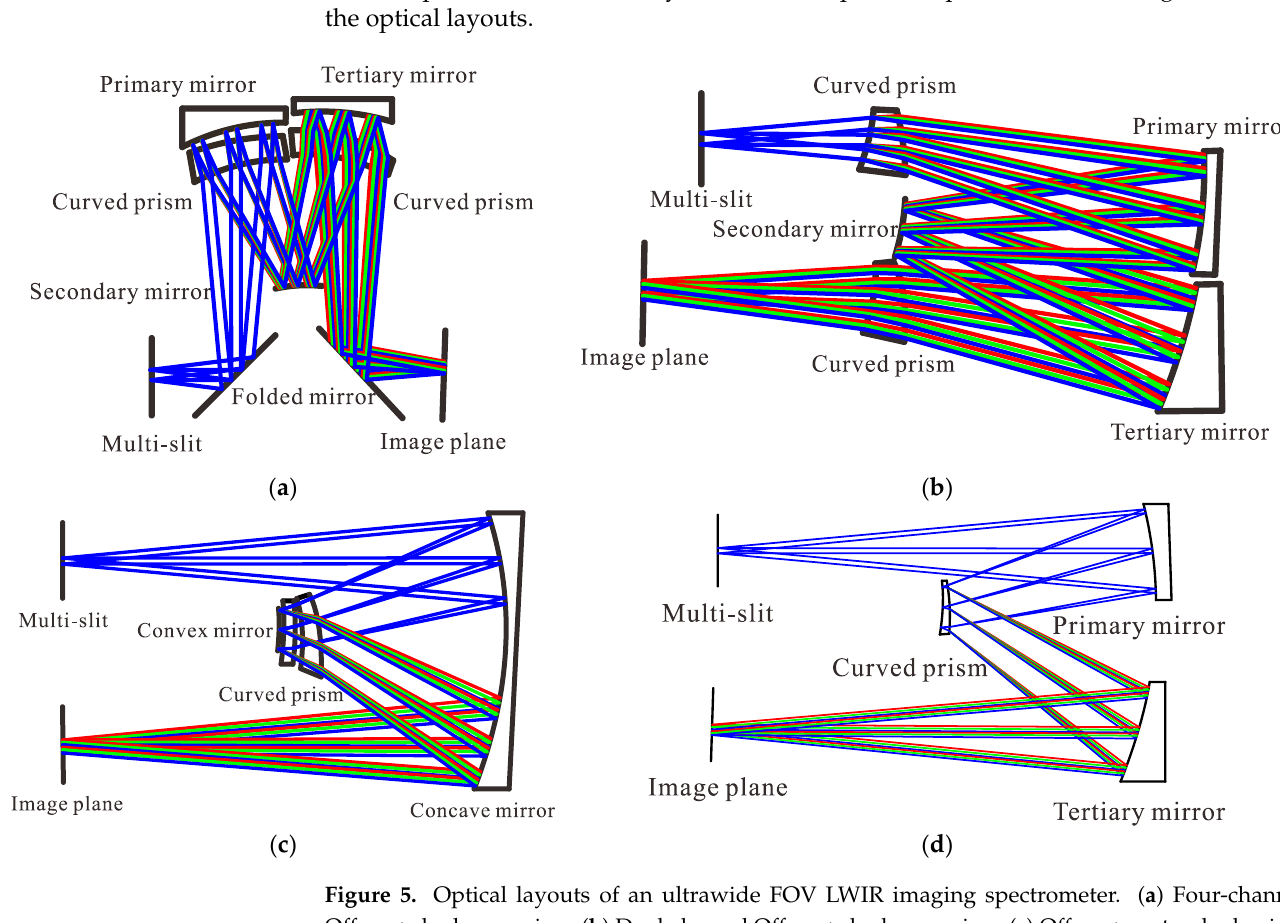
Figure 5. Optical layouts of an ultrawide FOV LWIR imaging spectrometer. ( a ) Four-channel Offner + dual-arm prism; ( b ) Dual-channel Offner + dual-arm prism; ( c ) Offner + center dual-prism; ( d ) Offner + center single prism.